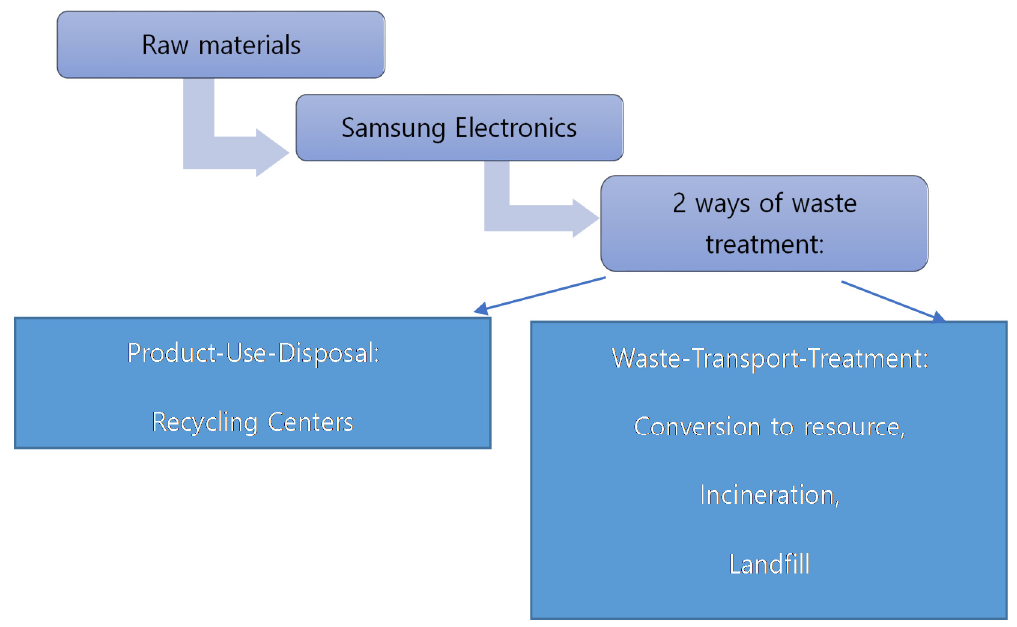
Figure 2. Waste treatment process in Samsung Electronics [36].